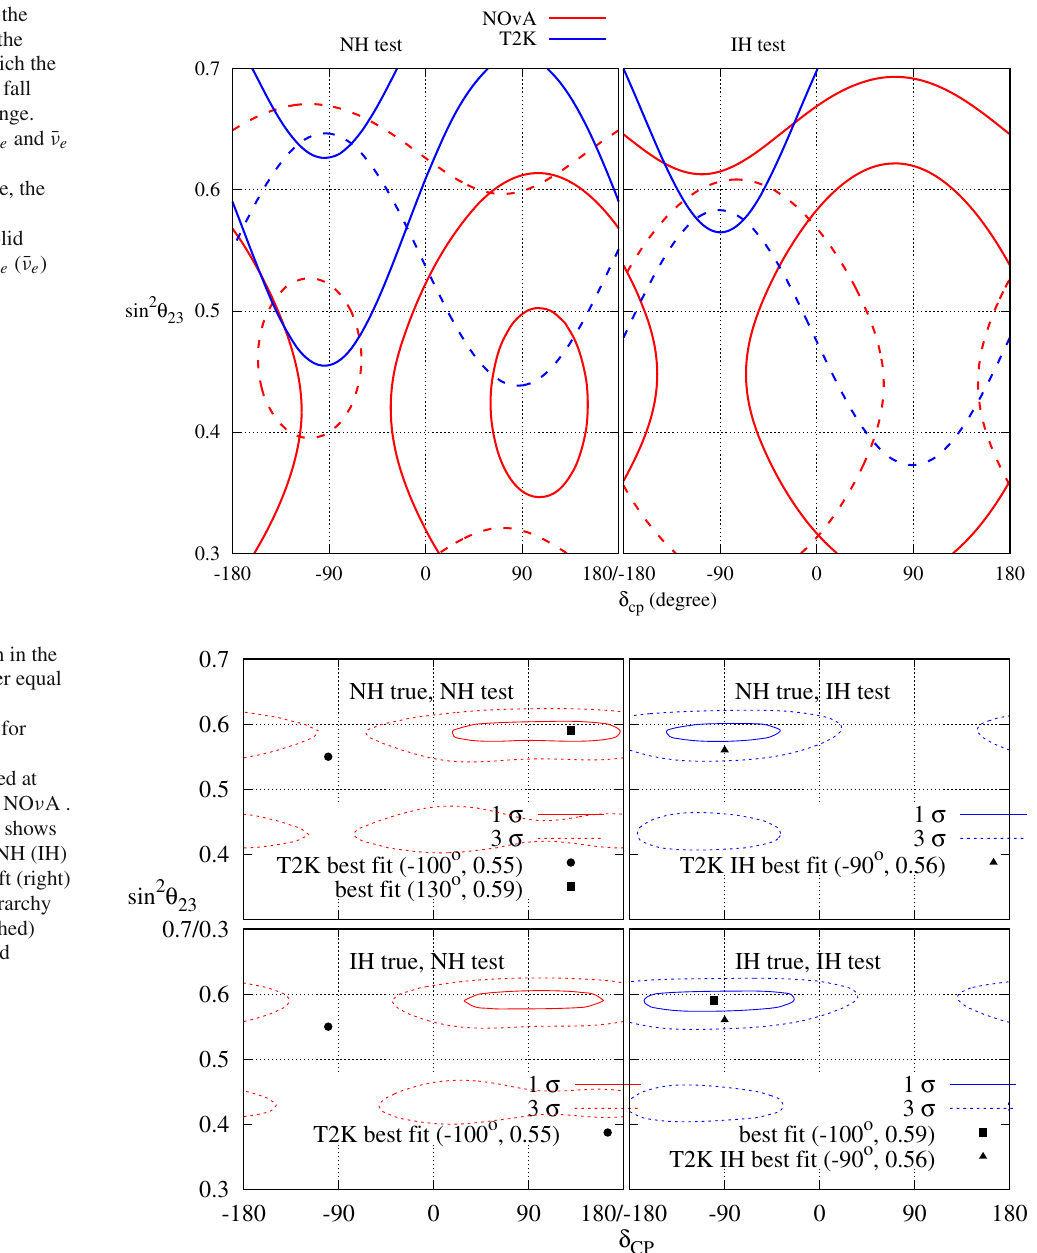
Fig. 9 Contour plot on the sin 2 θ 23 − δ CP showing the parameter values for which the expected event numbers fall √ N obs range. within N obs ± N obs for NO ν A (T2K) ν e and ¯ ν e are 82 (107) and 33 (15) respectively. In the figure, the red (blue) lines indicate NO ν A (T2K) and the solid (dashed) lines indicate ν e ( ¯ ν e )